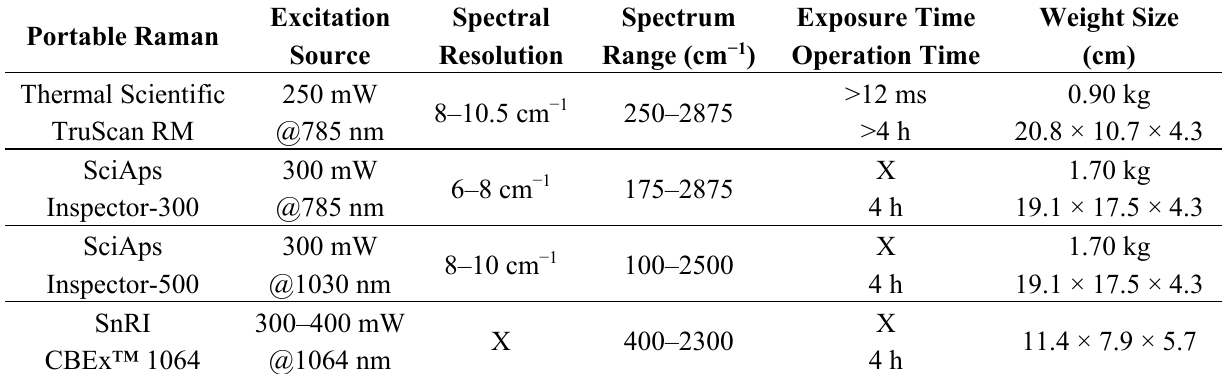
Table 7. Commercially developed portable Raman